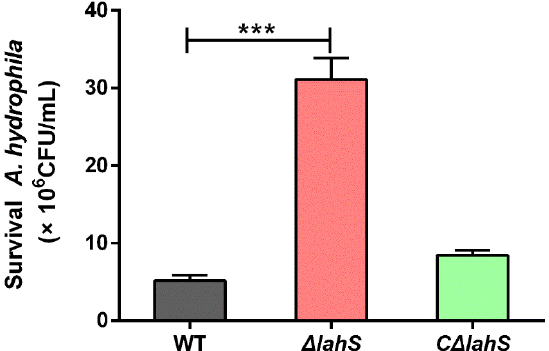
Figure 7. Oxidative stress resistance of the wild-type and lahS mutant strains. The effect of hydrogen peroxide on cell viability was examined to investigate the role of lahS in the resistance of A. hydrophila to oxidative stress. The H 2 O 2 resistance levels were expressed as the colony-forming unit (CFU) of the viable A. hydrophila after treatment with H 2 O 2 . Data are presented as the means ± SEM of three independent experiments. *** p < 0.001.